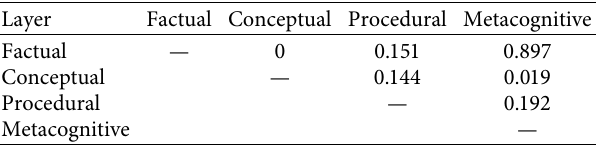
Table 9: Frobenious distance calculated between all pairs of nodes in each layer